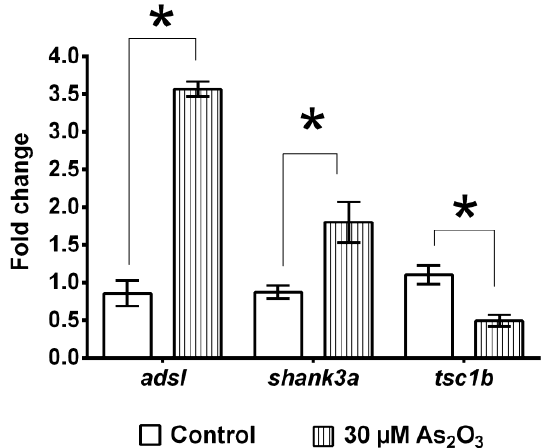
Figure 6. Embryonic exposure to As 2 O 3 induced alterations in transcriptional regulation of ASD- associated genes. As 2 O 3 exposure resulted in significant overexpression of adsl and shank3a , whereas tsc1b was downregulated. Data are presented as the mean ± SEM, (* p < 0.05) ( n = 90 per group).